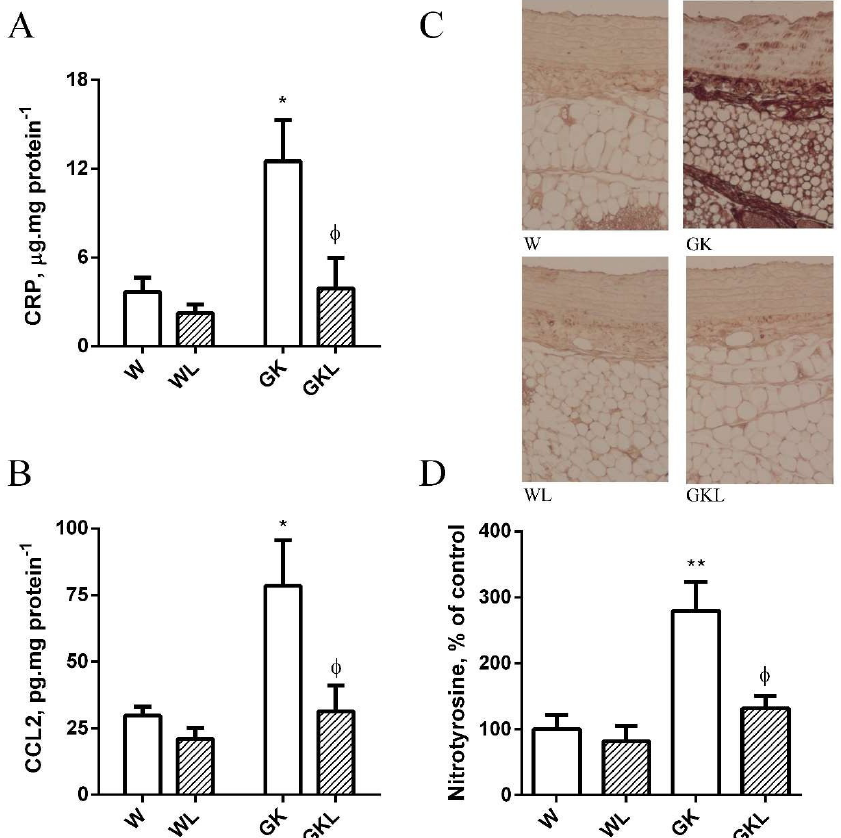
Figure 6. Effects of luteolin on inflammation of perivascular adipose tissue (PVAT) in thoracic aorta from Wistar and Goto-Kakizaki (GK) rats. CRP ( A ) and CCL2 ( B ) levels; immunohistochemical staining for nitrotyrosine ( C , D ) were determined in PVAT of thoracic aortas of the different groups of rats. Data are expressed as mean ± SE. * p < 0.05, ** p < 0.01 vs. W group; ϕ p < 0.05 vs. GK group.